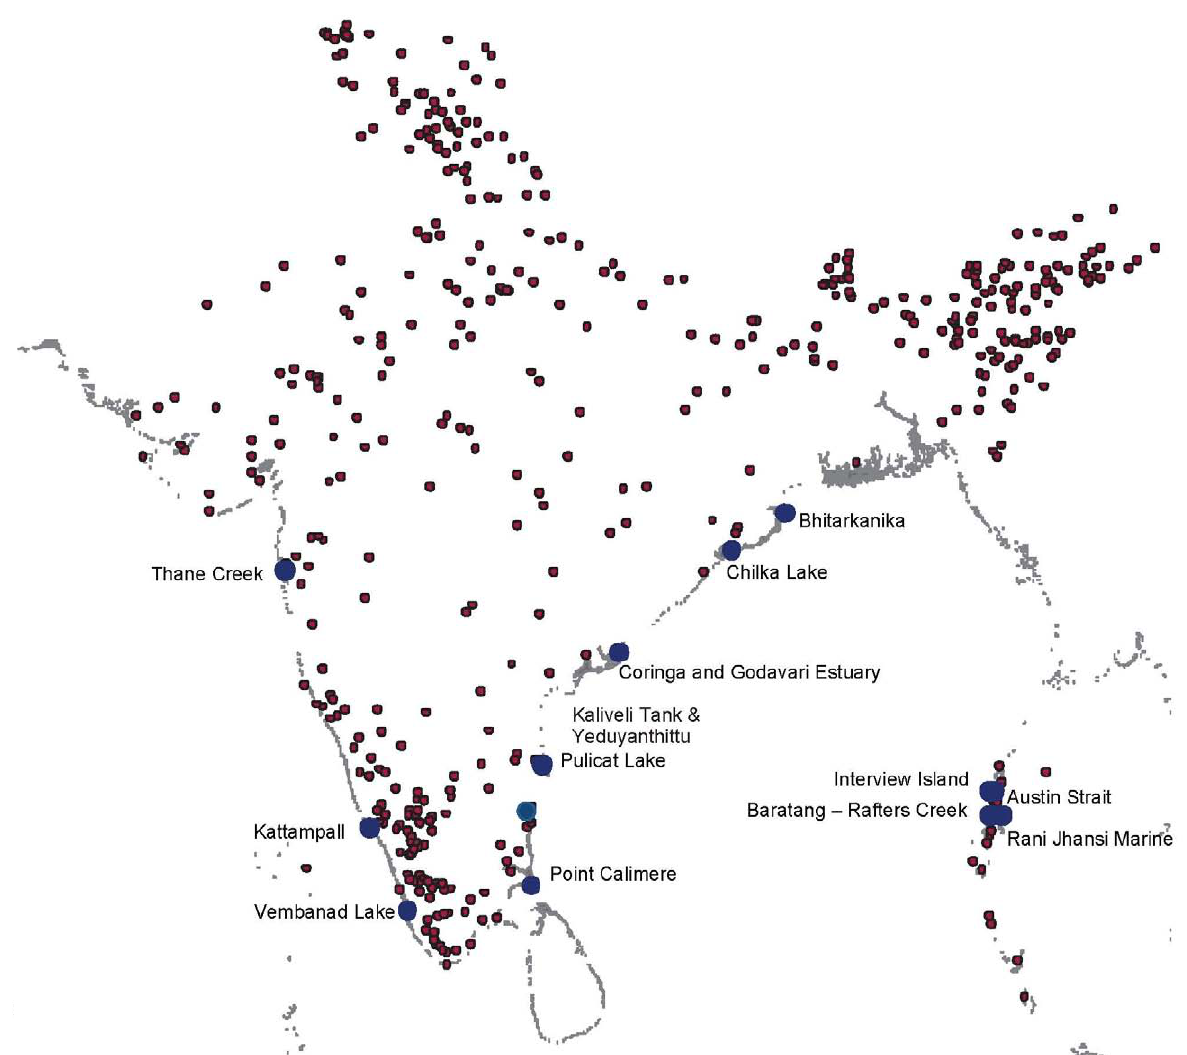
Figure 1a. Important Bird Areas (IBAs) directly affected by a 1m sea-level rise, shown as solid blue circles. Other IBAs are shown as red circles and inundated areas appear in